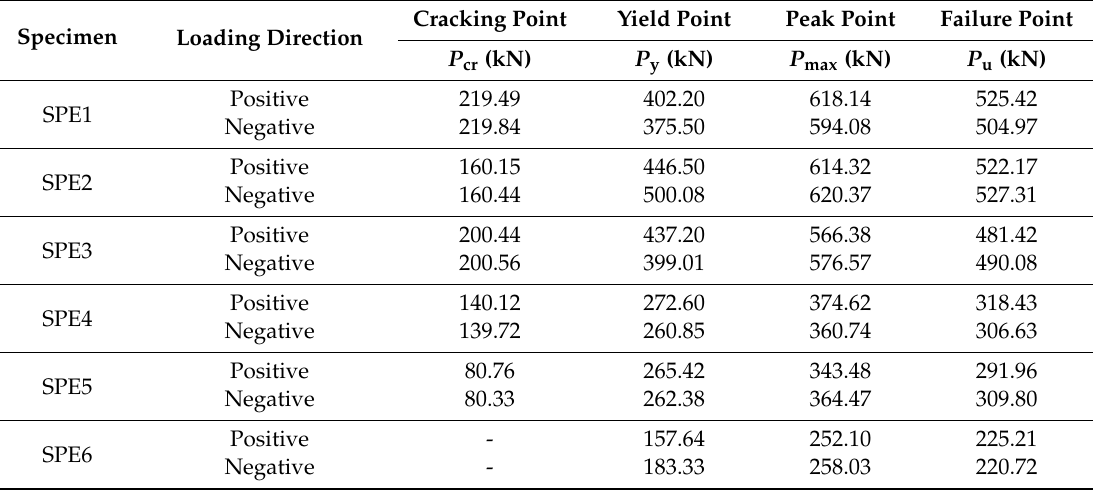
Table 4. Loads of main characteristic points on skeleton